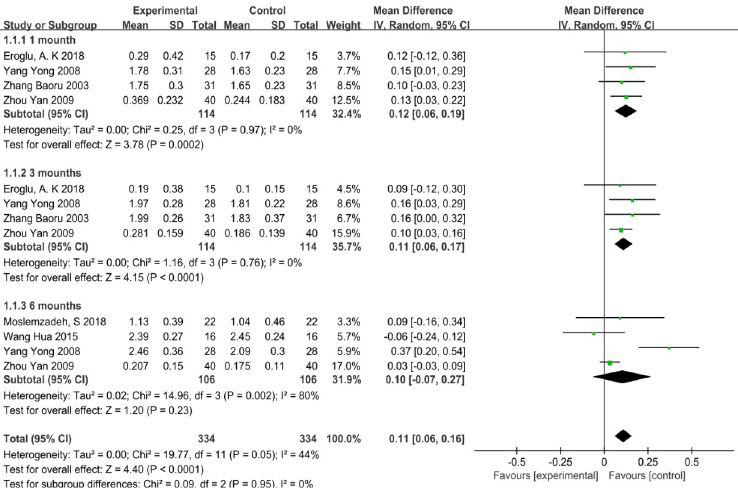
Fig 4. The status of GI index at 1, 3, and 6 months between the VFR group and the Hawley group.